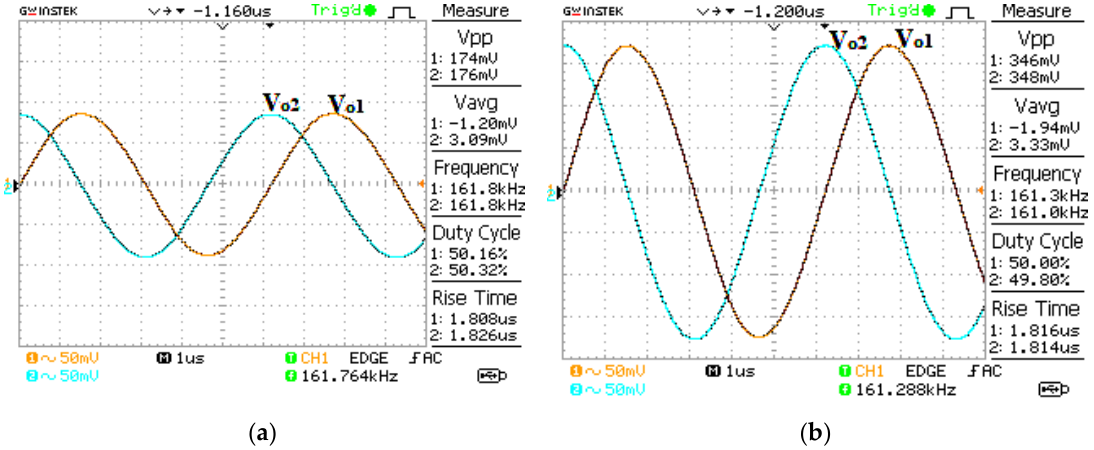
Figure 7. Measured sinusoidal output waveform ( a ) v o1 and v o2 , and ( b ) v op1 and v op2 .